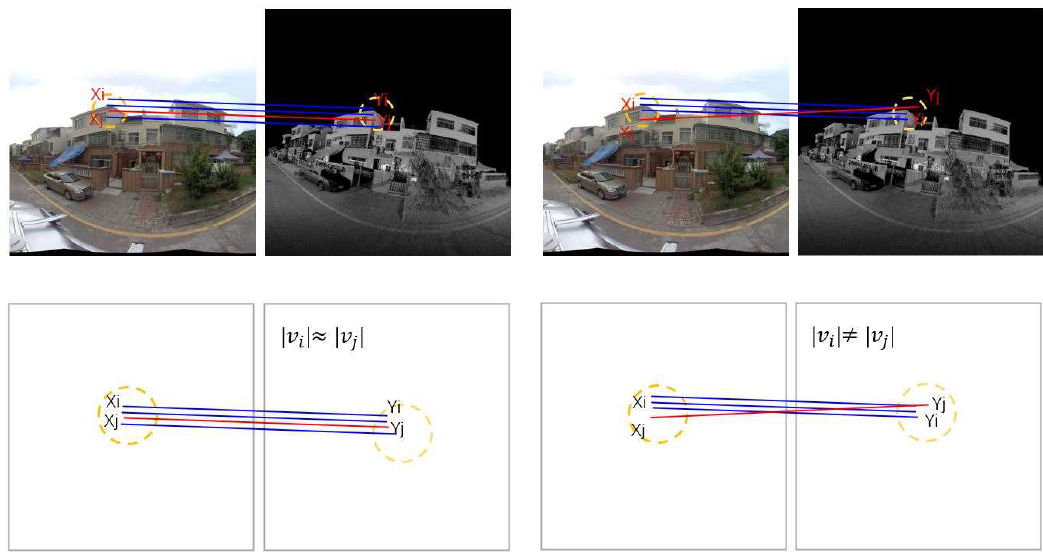
Figure 6. Local neighborhood